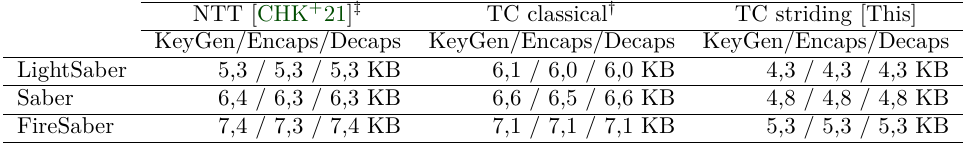
Table 6 Comparison of the memory utilization of Saber on Cortex-M4 processor when implementing different polynomial multiplication